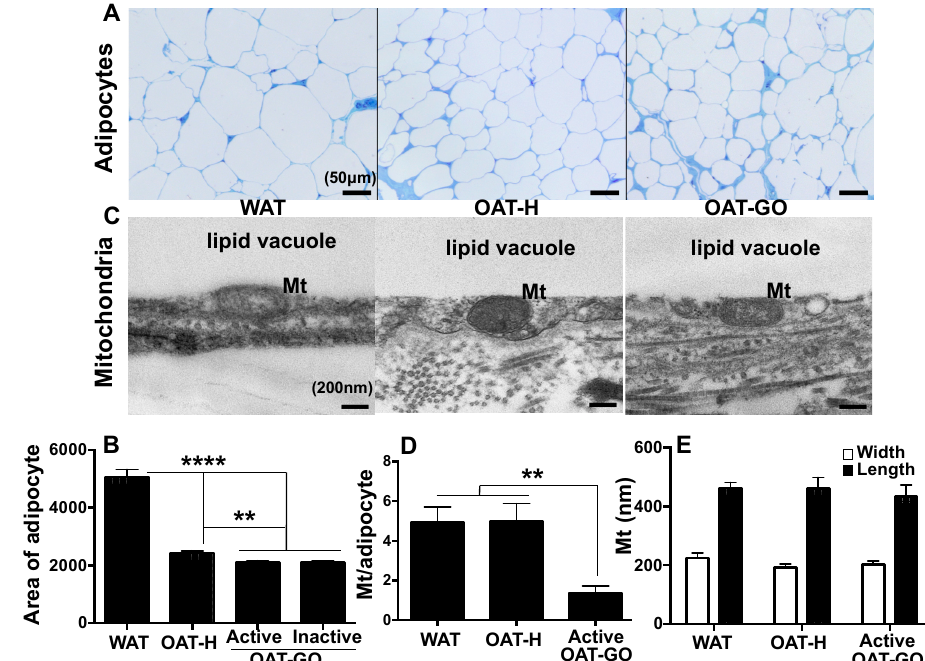
Figure 1. Adipocyte and mitochondria analysis of white-adipose-tissue (WAT), healthy orbital adipose tissue (OAT-H) and OAT- Graves’ Orbitopathy (GO). ( A ) Representative photomicrographs show toluidine blue-stained sections of WAT, OAT from healthy individuals (OAT-H) and OAT from GO patients (OAT-GO) (scale bar 50 µ m) by light microscopy; and ( B ) area of adipocytes ( µ m 2 ) was investigated. ( C ) Representative photomicrographs of adipocyte mitochondria (Mt) are shown by electronic microscopy (scale bar 200 nm); ( D ) numbers of mitochondria (Mt) per adipocyte, ( E ) length and width (nm) of mitochondria from each study group were analyzed. Histograms = mean ± SEM of all samples studied, p value indicated in the figure, ** as p < 0.01, **** as p < 0.0001.